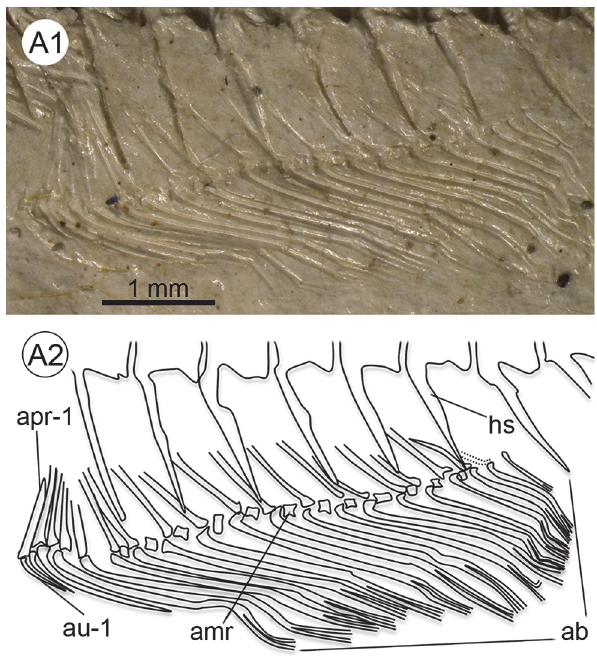
Fig 8. Details of the anal fin of † Kenyaichthys kipkechi sp. nov. (paratype 1177´04). A1 – A2 Anal fin with three short rays, 17 long rays and 19 proximal radials (last ray not supported by proximal radial), left lateral view. Abbreviations: ab, branched rays of anal fin; amr, anal medial radial; apr-1, first anal proximal radial; au- 1, first unbranched anal fin ray; hs, haemal spine.